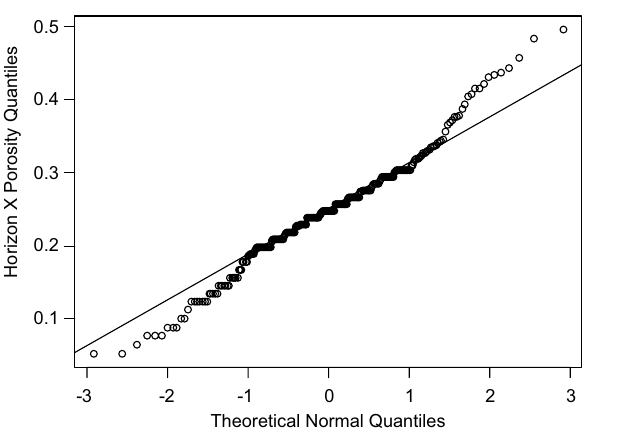
Fig. 11 Normal Quantile–quantile plot of individual porosity val- ues—Horizon X